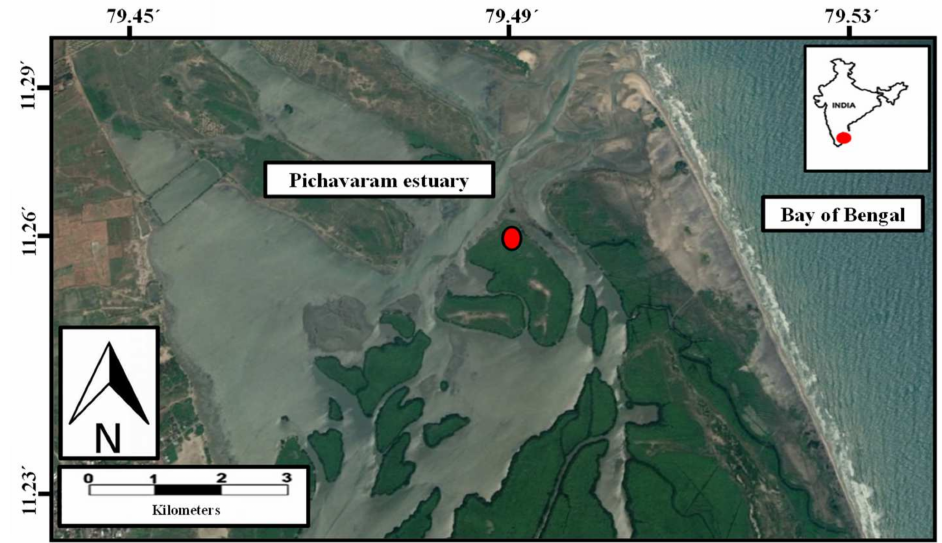
Figure 1. Map of the study area within Pichavaram estuary. Red circle indicates the sampling site.